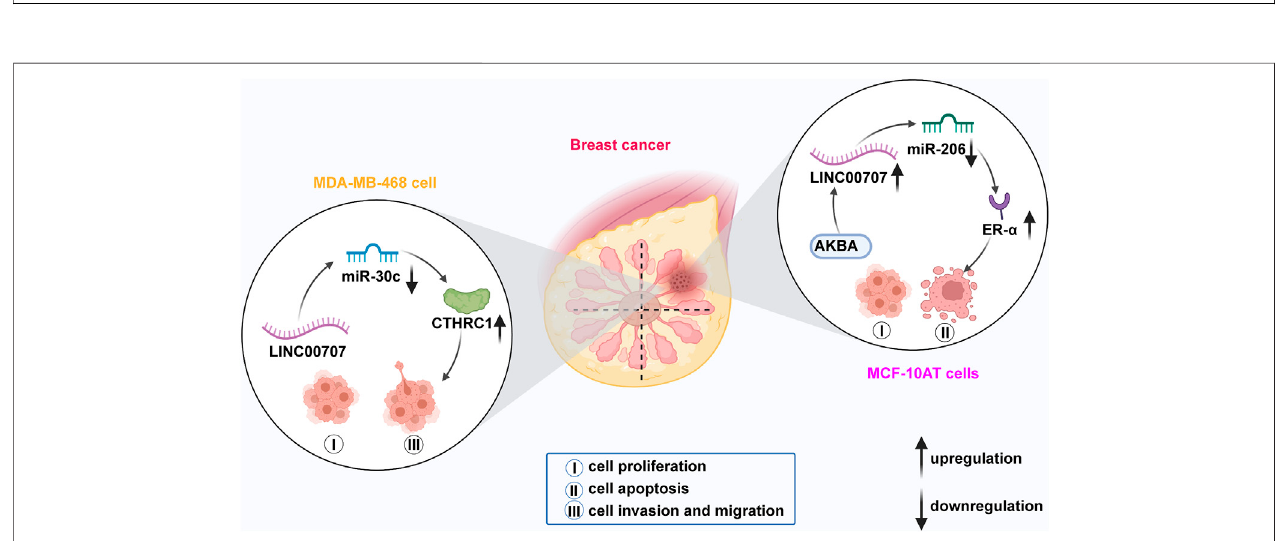
FIGURE 1 | In lung adenocarcinoma, LINC00707 participates in mediation of the processes of cell proliferation, apoptosis, and migration by upregulating Cdc42 expression or combining with miR-338-3p and further increasing AHSA1 level.